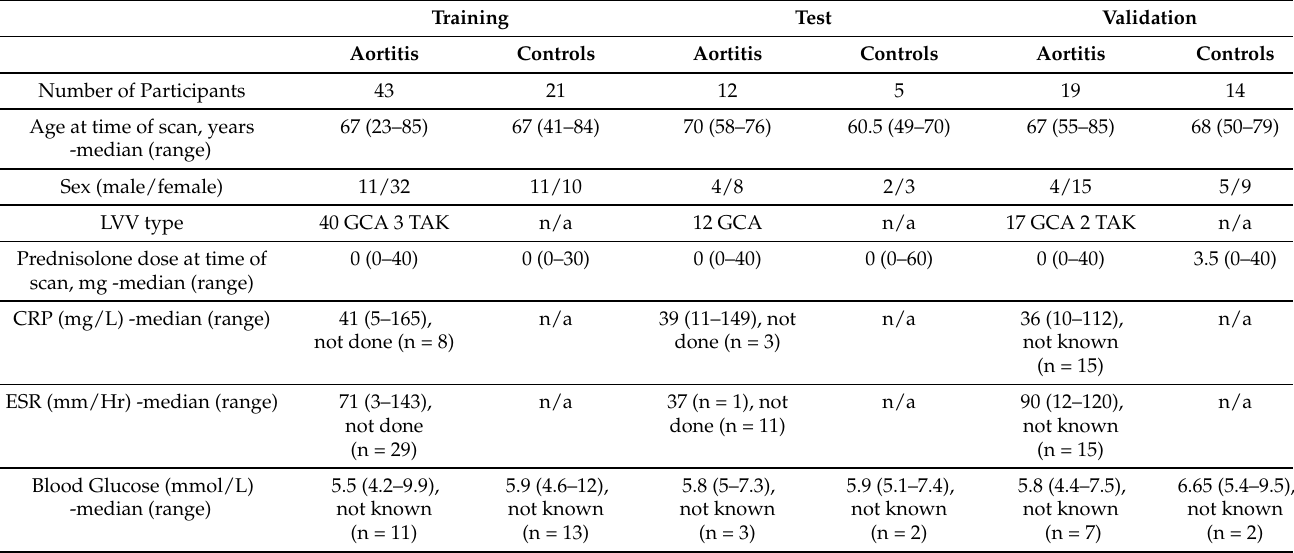
Table 2. A description of patient demographics across the three datasets Key—Large vessel vasculitis (LVV), giant cell arteritis (GCA), Takayasu’s arteritis (TAK), Not applicable (n/a), CRP (C-reactive protein), ESR (erythrocyte sedimentation rate).